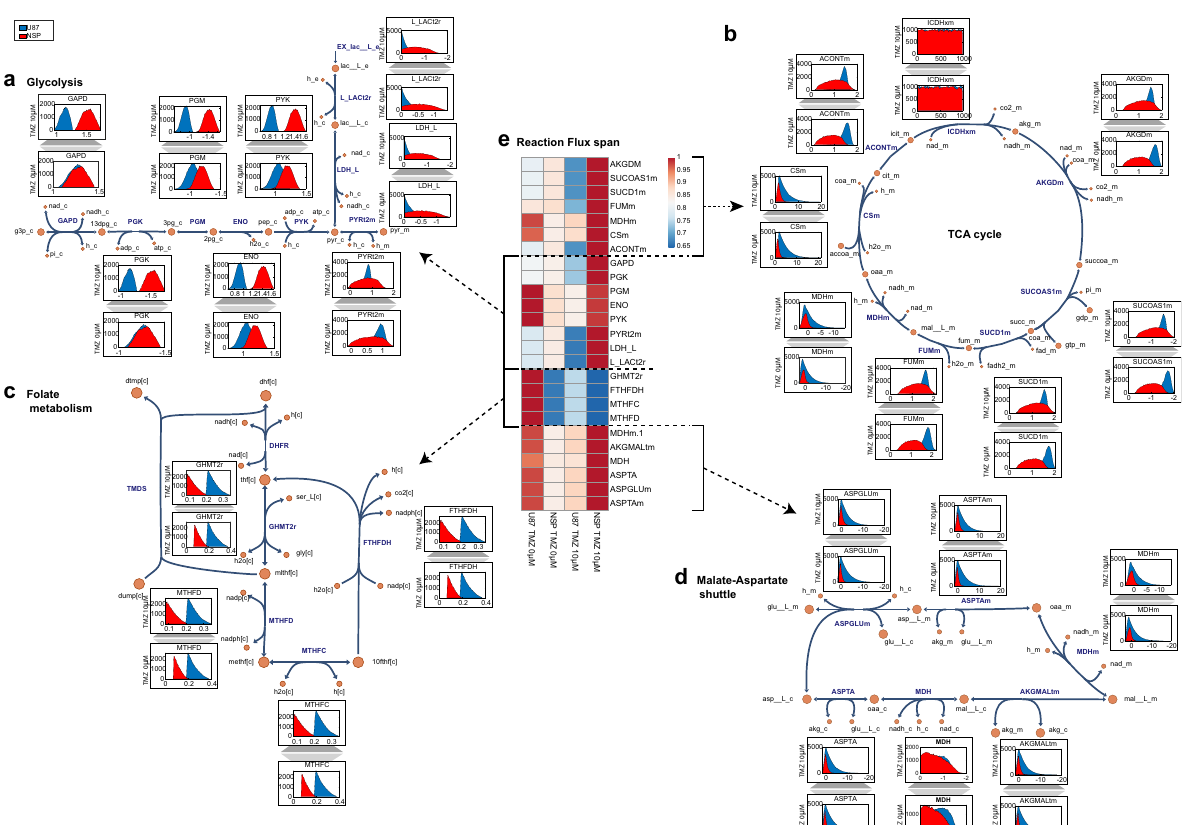
Fig. 3 Constraints-based metabolic modeling of Glioblastoma predicts targetable alternate fl ux distributions in the metabolic pathways of temozolomide resistant cells. a-d Differential predicted fl ux spans and probability of fl ux distribution using monte-carlo sampling (blue – U87MG; red – NSP) for ( a ) Glycolytic pathway. (b) TCA cycle. (c ) Folate metabolism and ( d ) Malate-aspartate shuttle. e Differential fl ux spans predicted in silico using fl ux variability analysis (FVA) for U87MG and NSP associated with reprogrammed pathways (arrows point towards their associated pathways showing predicted probability of fl ux